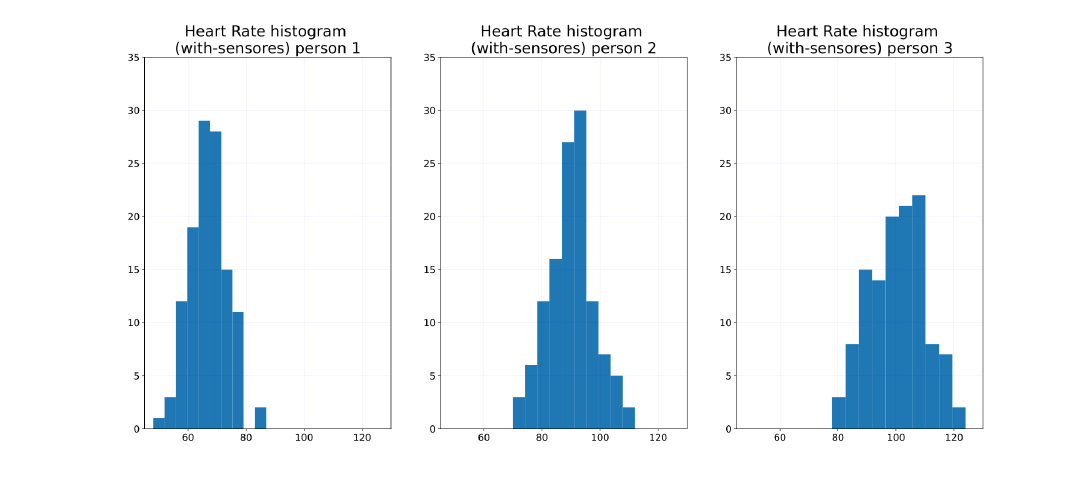
Figure 7. Time series of heart rate of three persons.